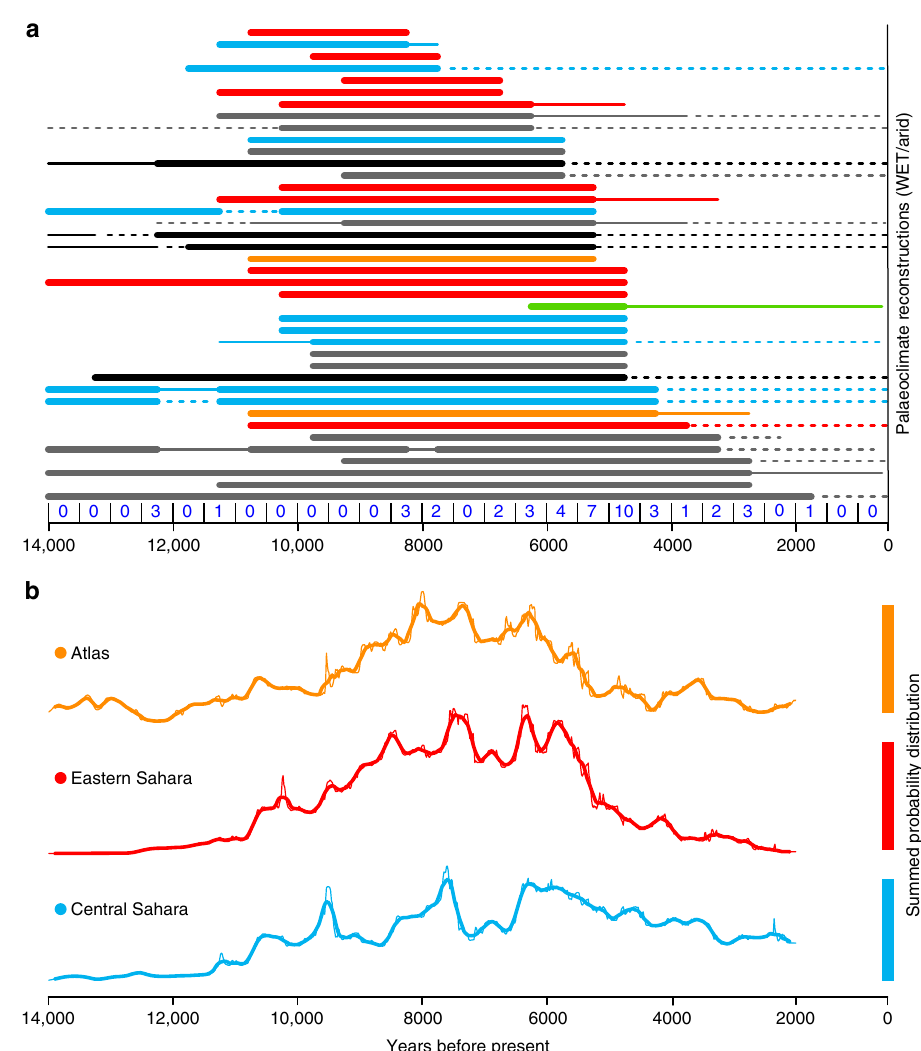
Fig. 2 Reconstructions of Holocene northern Africa. a Palaeoclimate reconstructions 3 showing the existence of wet conditions (thick solid lines), semi-arid conditions (thin solid) or arid conditions (dashed). The individual reconstructions are colored by region: Central Sahara (Blue), Eastern Sahara (Red), the Atlas & Hoggar Mountains (Orange). The records discussed in the text are Lake Yoa 17 (green) and marine cores 13,14 (black), whilst records outside of the population regions are coloured gray. The records shown in order of their wet/dry transition, and the total number of wet/dry transitions is shown for each 500 year period. b Probability density of dated archaeological fi nds for the three regions in northern Africa, which can be used to infer the